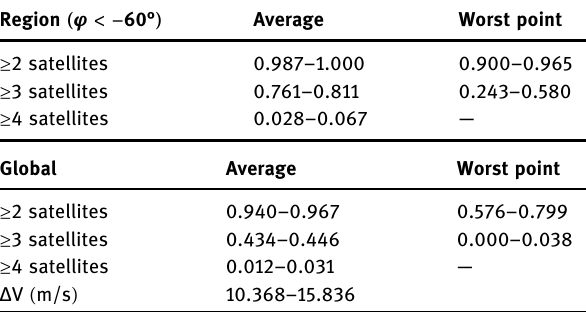
Table 2: LNSS availability performance over a 10 year lifetime as a daily probability of a given number of satellites in view in a polar region and globally